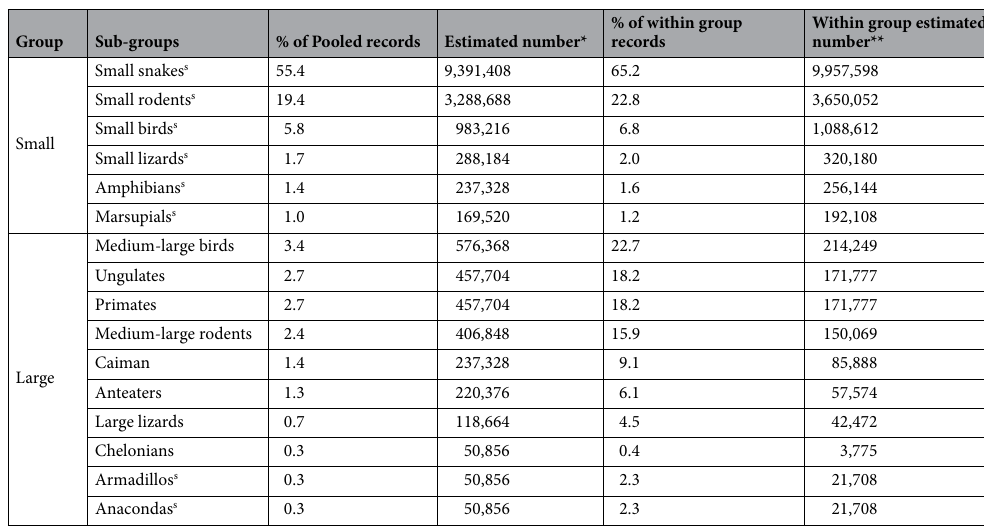
Table 2. Descending order of the estimated number of dead animals in sub-groups within the small (Small) and the medium to large (Large) vertebrate groups during the wildfires that hit the Brazilian portion of Pantanal wetland in 2020. *In relation to the estimated pooled records of dead animals (small vertebrates plus medium to large vertebrates. **In relation to the estimated number of dead animals in the small vertebrates and the medium to large vertebrate groups, separately. s Subgroups of vertebrates considered as underestimated (see